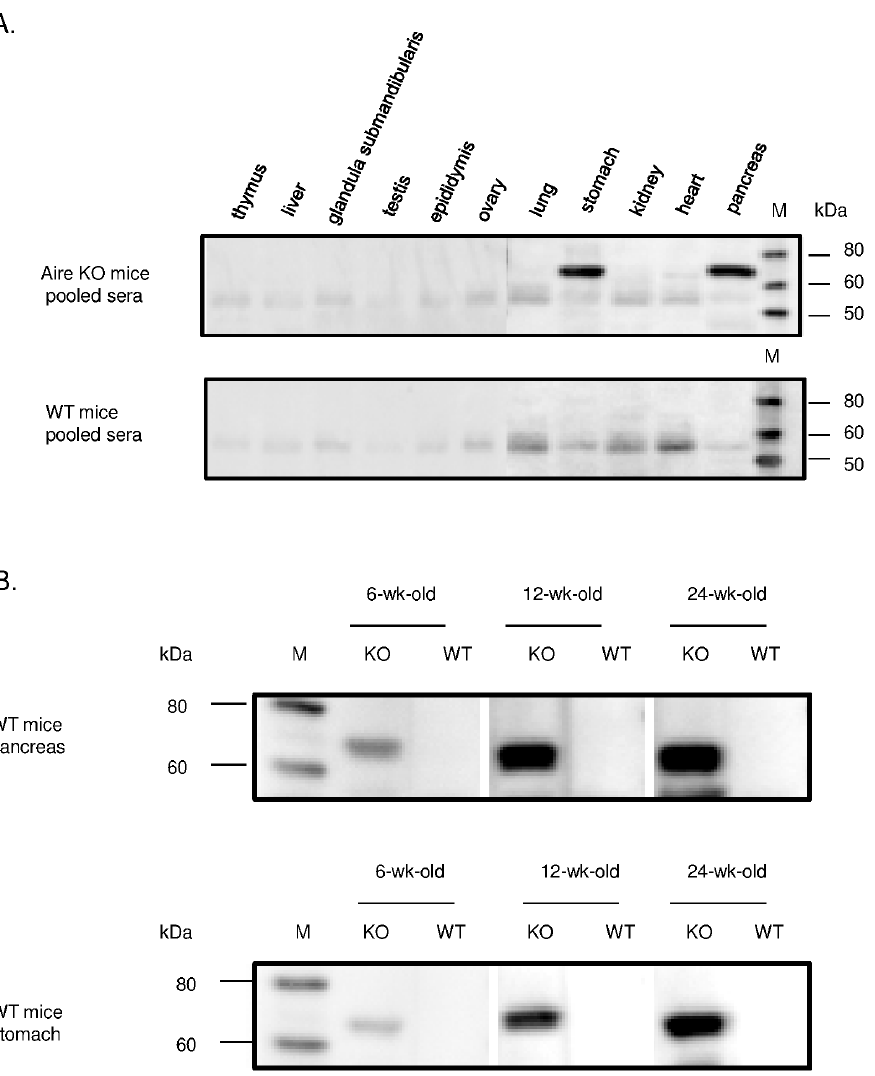
Figure 3. The search for target antigen in Aire KO mice serum with Western blotting. A. With the sample for the other organ tissue protein homogenates(thymus, liver, submandibular gland, testis, epididymis, ovary, lung, stomach, kidney, heart and pancreas), the search for autoantibody for tissue antigen. Upper shows Aire KO mice pooled sera for the primary antibody, lower shows WT mice pooled sera for the primary antibody. B. Western blotting for pancreatic and gastric protein with KO and WT mice pooled sera. M: marker.